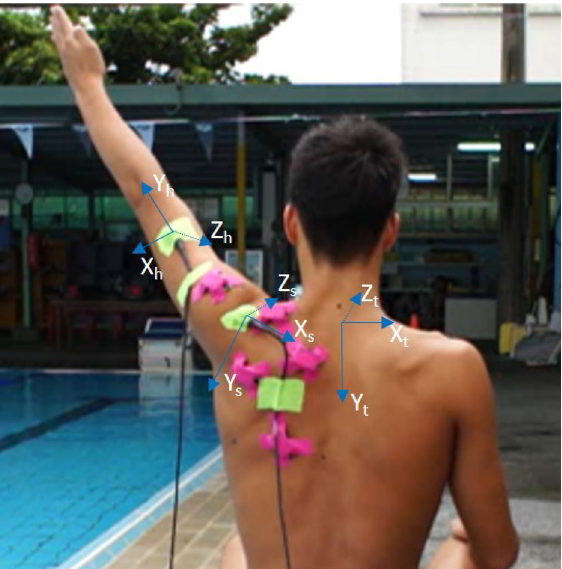
Figure 1. The swimmer’s left shoulder as the non-breathing side during swimming was evaluated. The LCS of thoracic ([X t , Y t , Z t ]), humerus ([X h , Y h , Z h ]) and scapula ([X s , Y s , Z s ]). The X axis is pointing towards the right, the Y axis inferiorly, and the Z axis